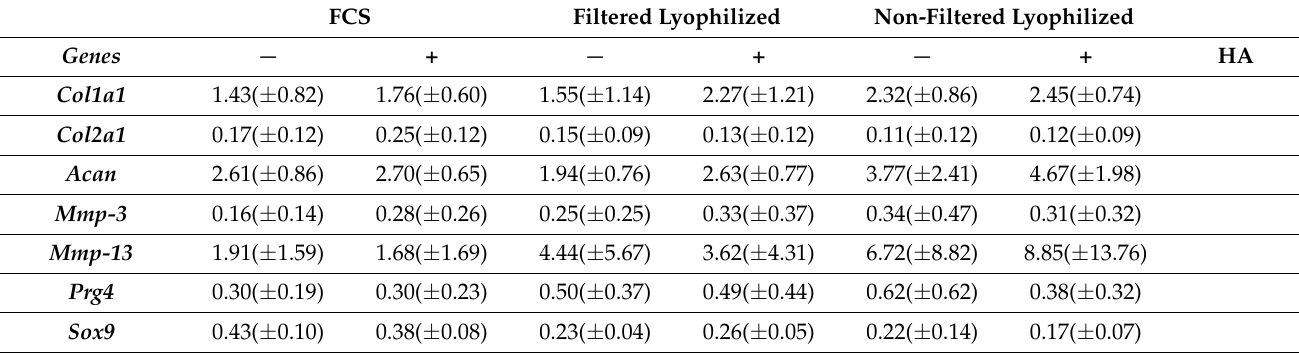
Table 2. Gene expression of OA-related genes after supplementation with HAS and HA. FCS